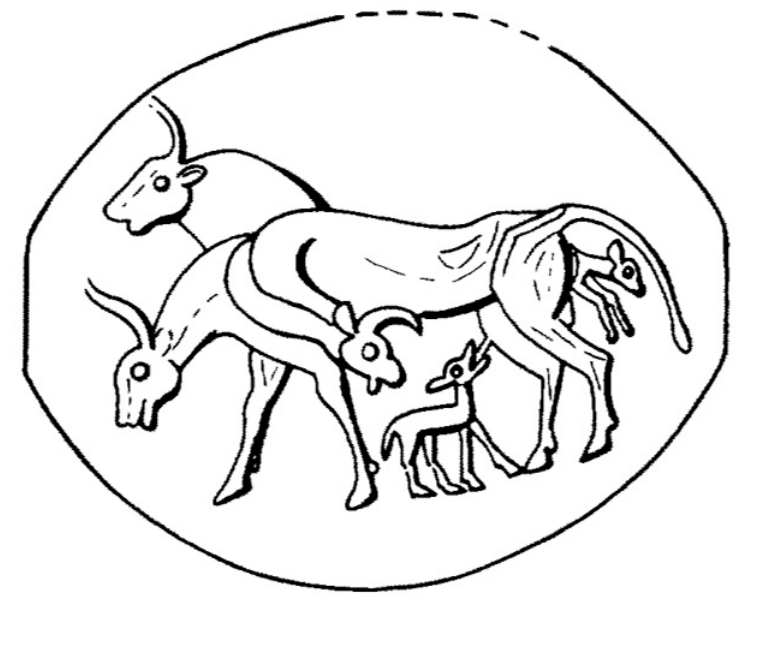
Figure 20. Akkadian stamp seal from Tell Brak, depicting the calving process (Delougaz 1968: Figure 18).